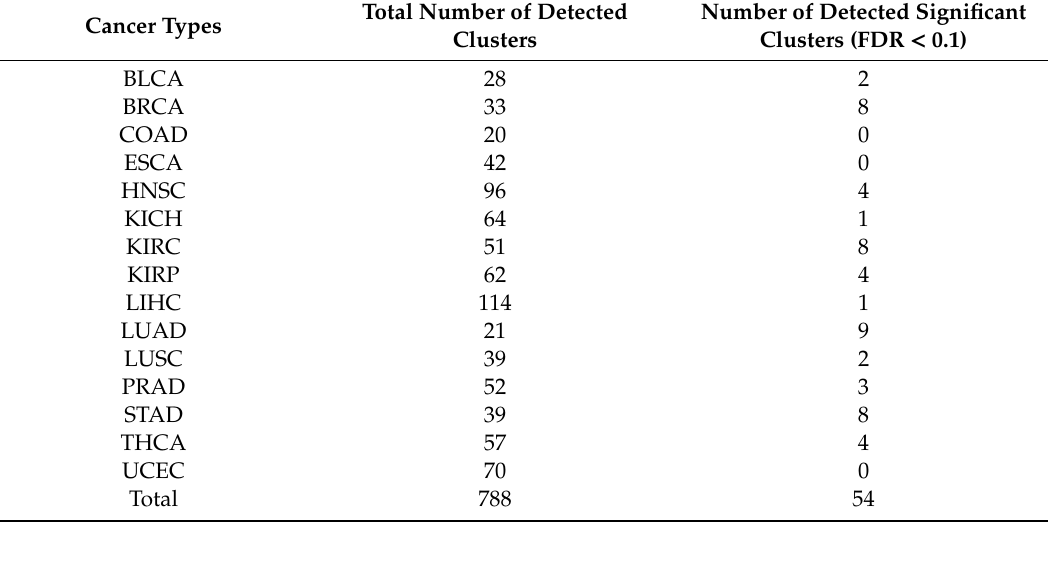
Table 2. The detected “communities” or “clusters” of significant pairs selected for each of 15 selected cancers from TCGA.